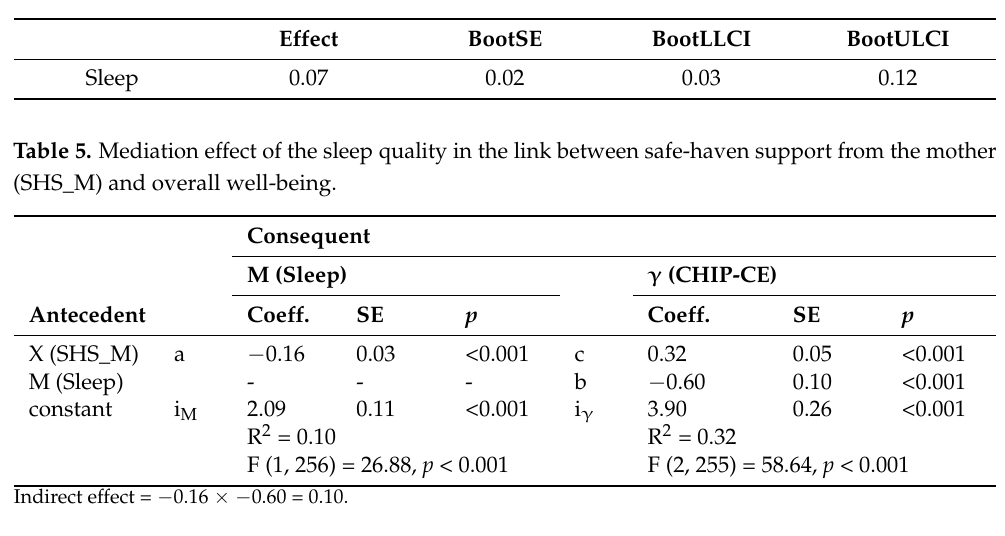
Table 4. Indirect effect of the secure base support from the mother (SBS_M) on sleep quality.